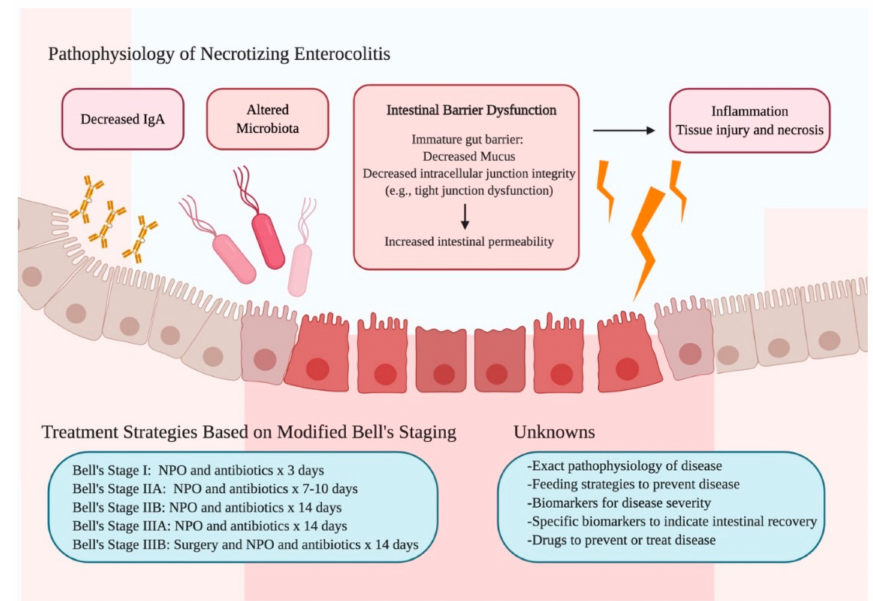
Figure 1. Summary of the Pathophysiology, Treatment Strategies, and Unknowns of Necrotizing Enterocolitis. The pathophysiology of NEC is multi-faceted, involving intestinal barrier dysfunction, decreased IgA, and altered microbiota. Current treatment strategies include stopping feeds and starting antibiotics based on disease severity, as classified by Bell’s staging. Much remains unknown about disease prevention, diagnosis, and treatment. Figure created with Biorender.com. Abbreviations: Immunoglobulin A (IgA), NEC (Necrotizing enterocolitis), NPO ( nil per os